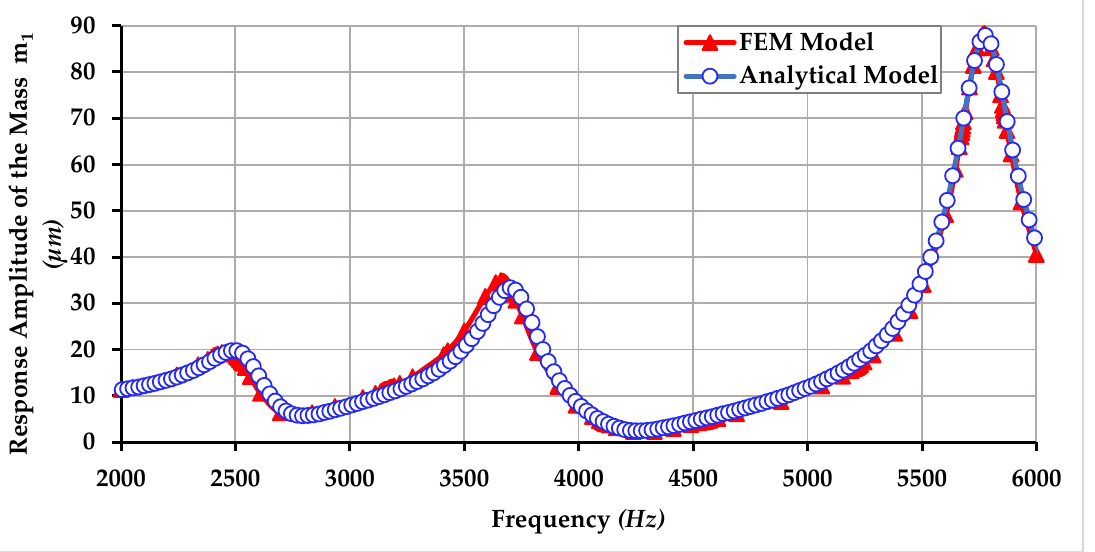
Figure 24. Comparison of response amplitude of the mass 𝑚 3 of the proposed MEMS gyroscope obtained using FEM and an analytical model. 5.4. Robustness Analysis: Table 4 shows the parametric fluctuations which could occur due to the limitation of the microfabrication process MetalMUMPs. The actual values of gain and new values of gain as a result of expected changes in the nominal values of the different structural parameters are also shown in the Table 5, which depicts that the proposed gyroscope has the potential to overcome the fabrication imperfections. Figure 25 shows the robustness of the proposed gyroscope against the environmental fluctuations, as there is the minor effect of environmental fluctuations on the gain of the proposed gyroscope dynamic response in the flat region between the first two resonant peaks.